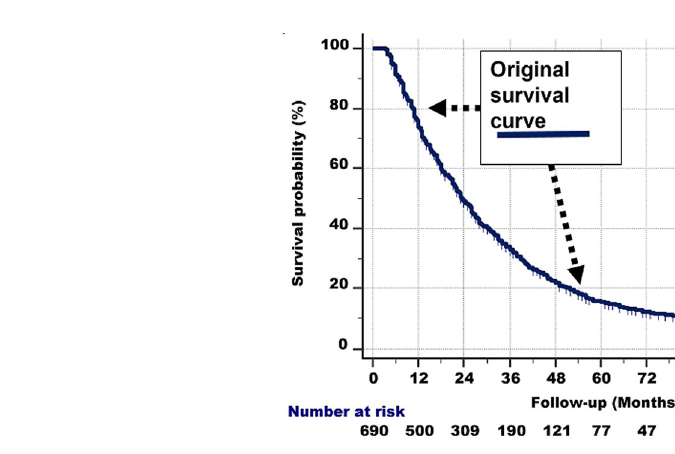
FIGURE 5 | Left: Survival curve of the whole group of 690 stage IV NSCLC patients with a 3.2 – 120.0-month follow-up, who had received conventional radiotherapy, platinum-based chemotherapy and tyrosine kinase inhibitor-targeted therapy.